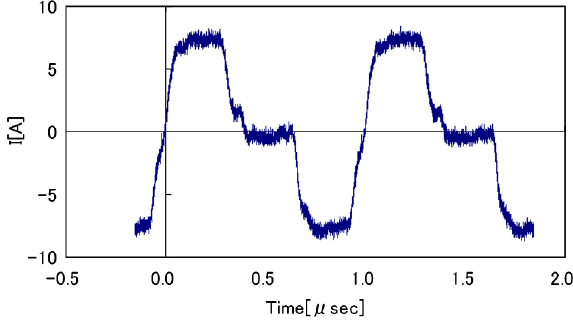
FIG. 40. Output current observed at the matching resistor of the acceleration cell.